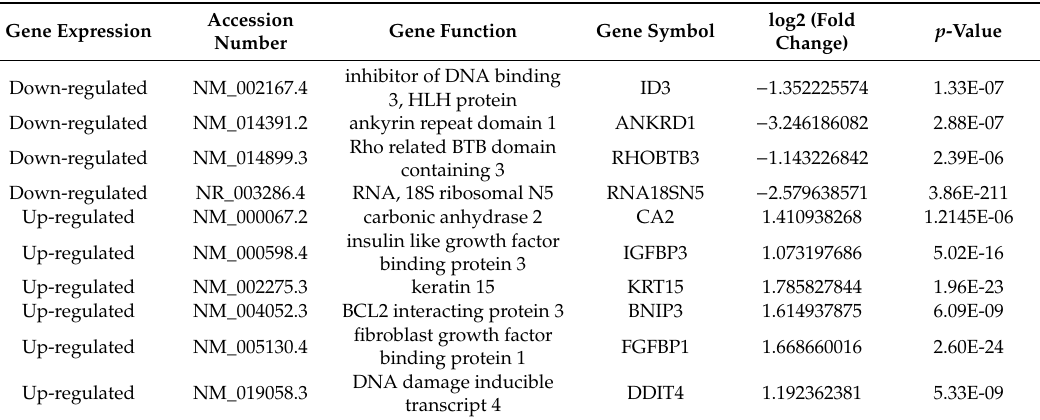
Table 6. Ten representative di ff erentially-expressed genes upon LACCE